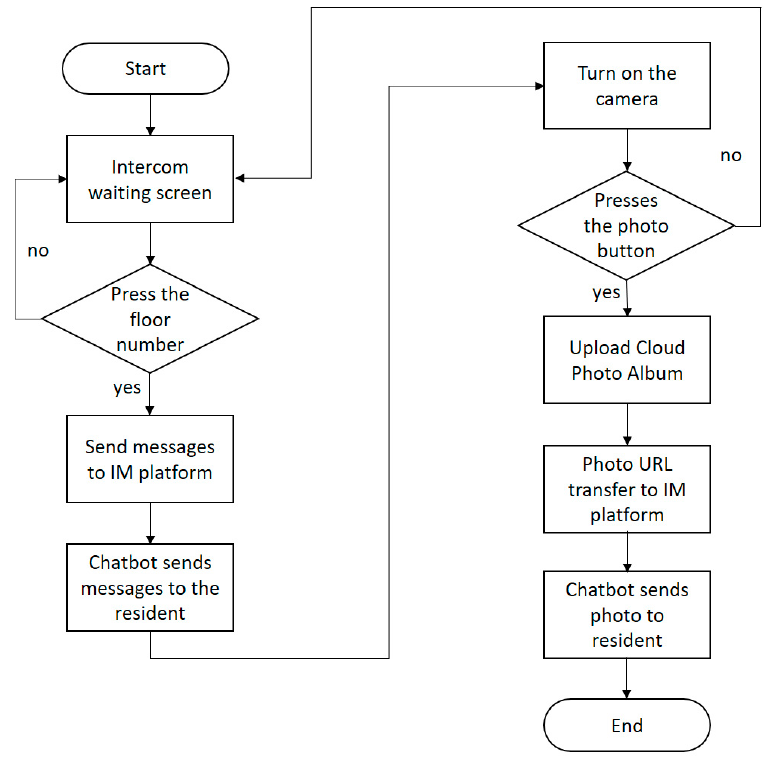
Figure 6. Function flow of the intercom.